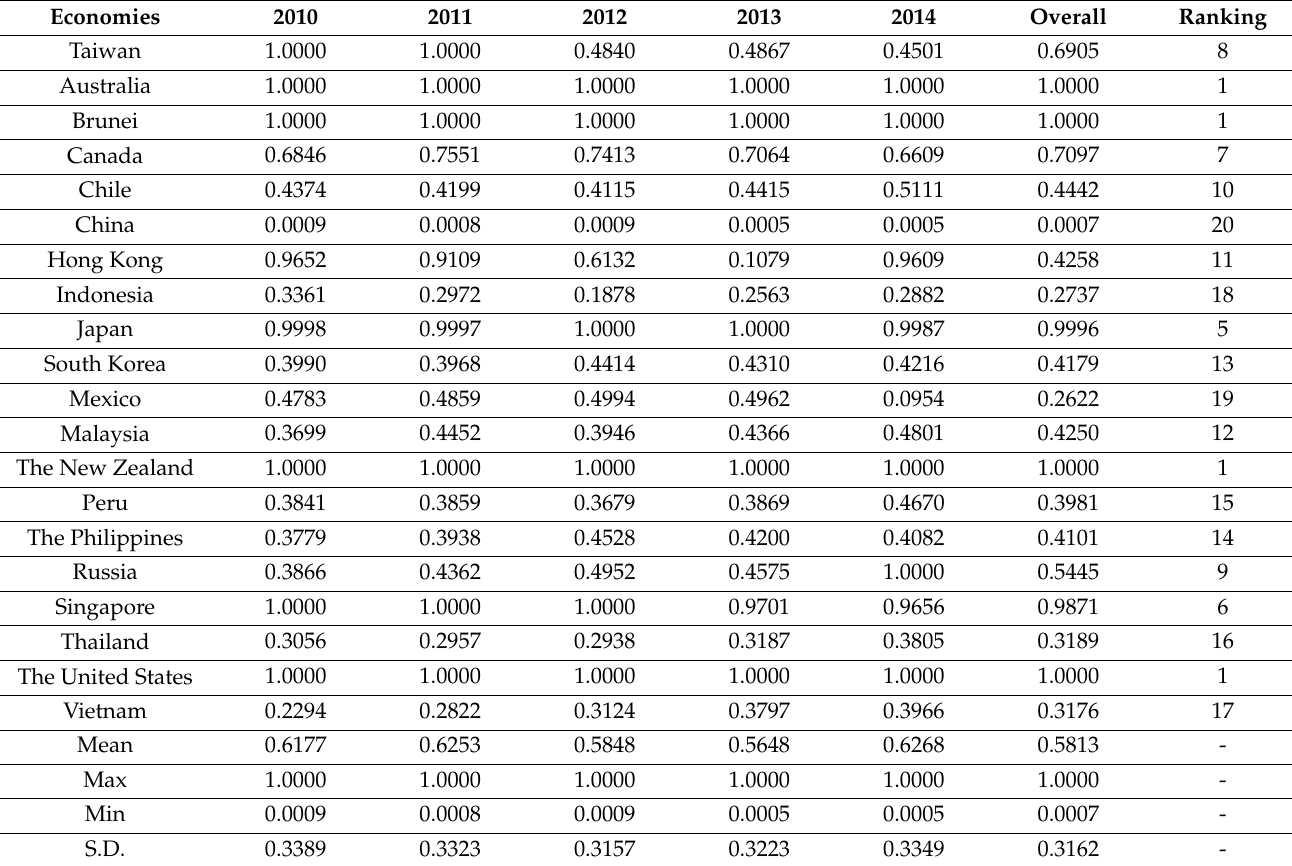
Table 6. The energy efficiency of APEC economies from 2010 to